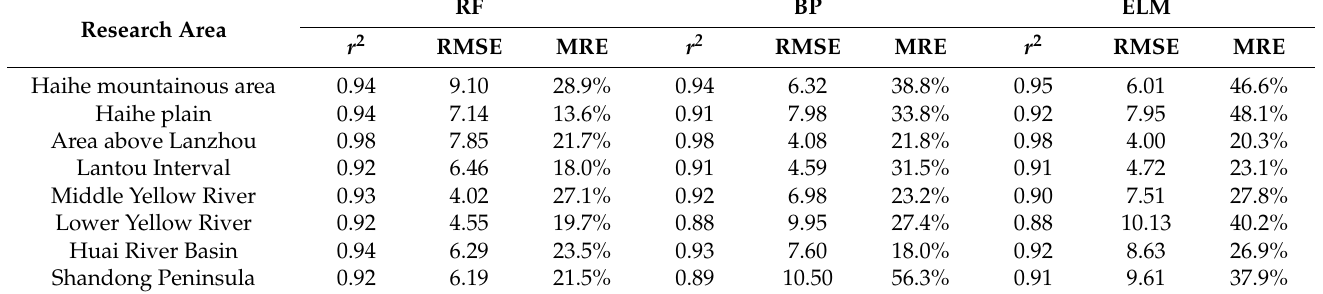
Table 3. Comparison of simulation results of machine learning test set.